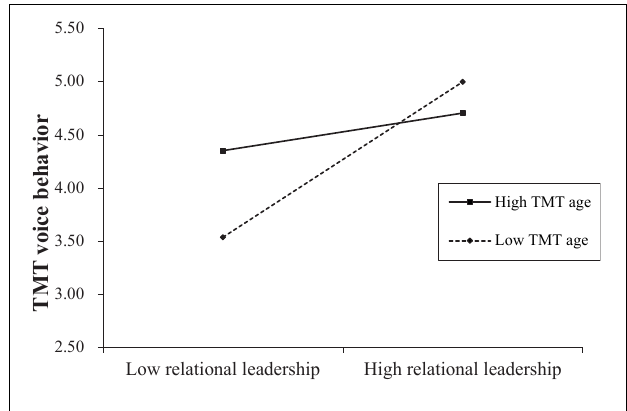
FIGURE 3 | The moderating role of TMT